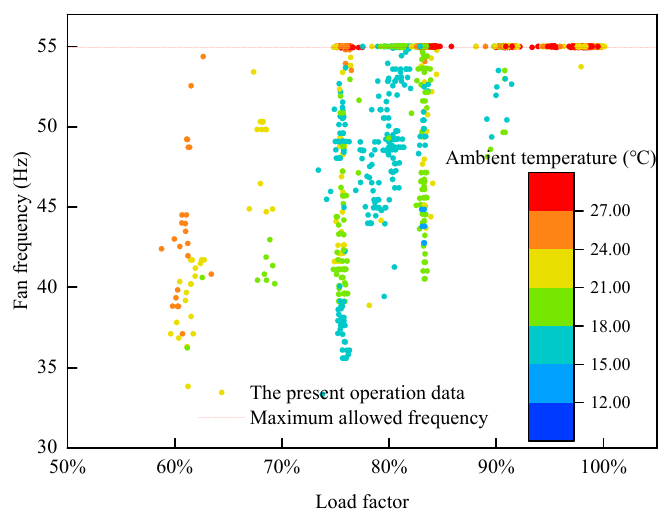
Figure 4. The present operation strategy of fan frequency.